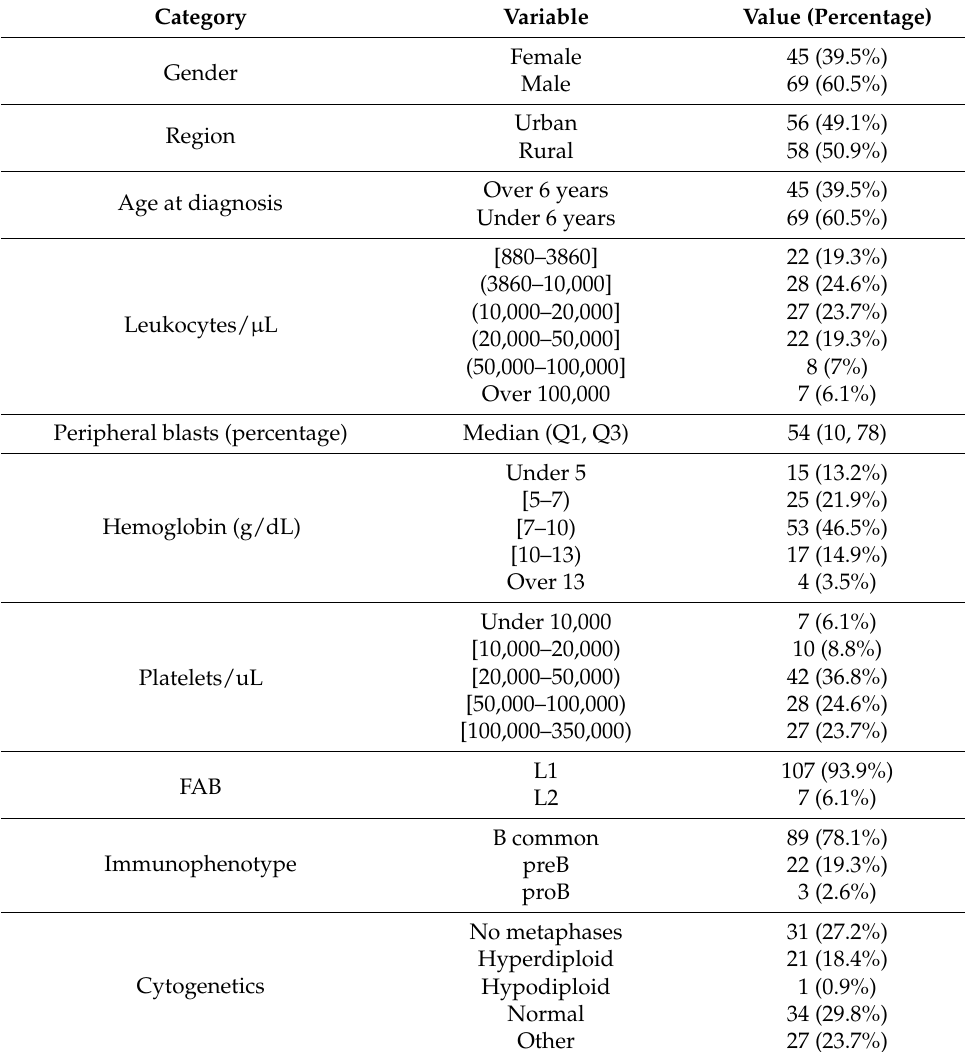
Table 1. General characteristics of the